Question: What visual encoding does this figure use to show its data?
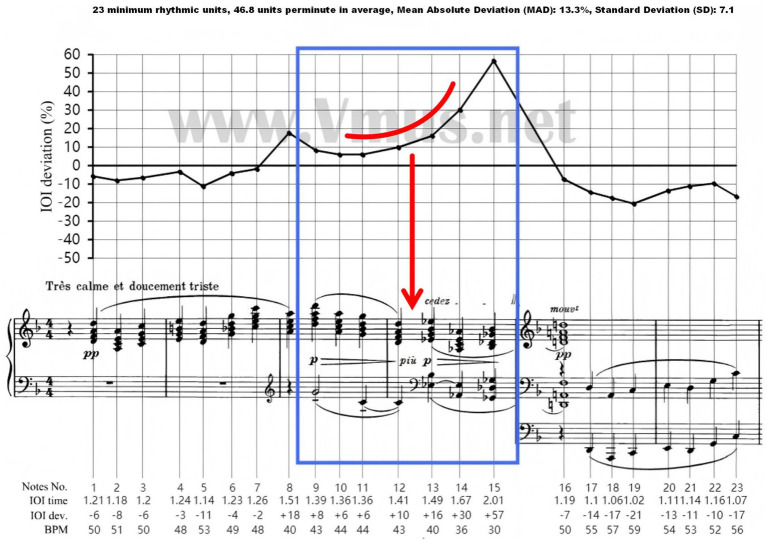
Answer: line